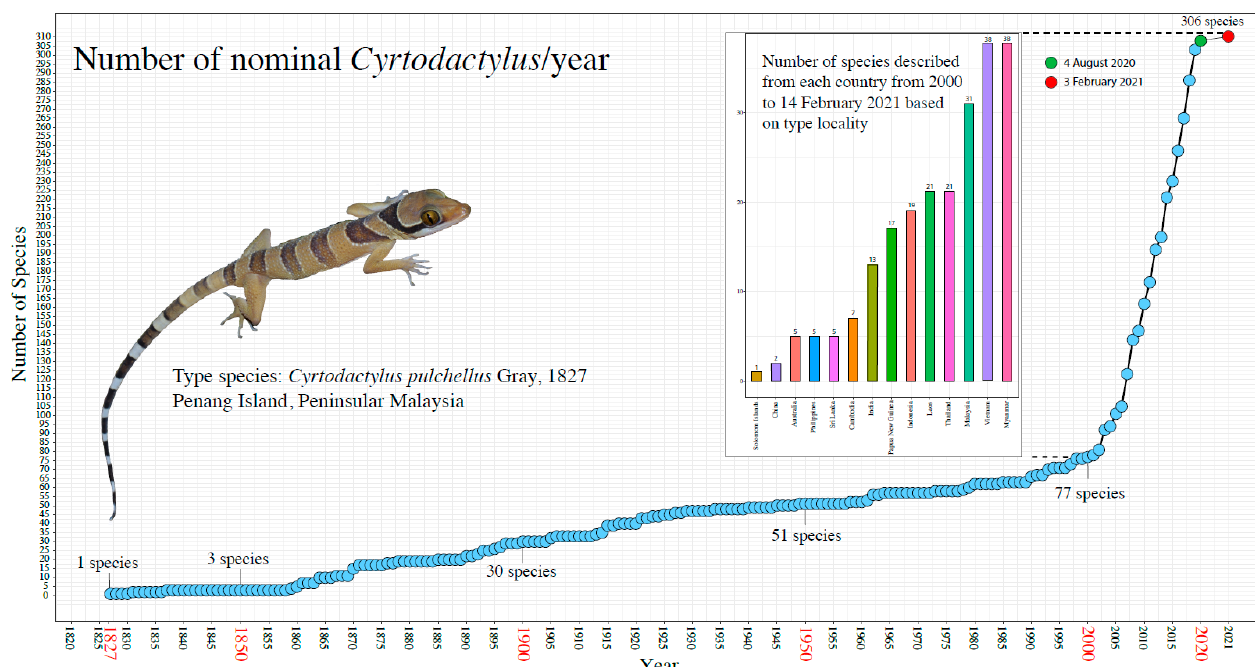
Figure 5. Cumulative number of species of Cyrtodactylus described per year. The trajectory of new species descriptions from 2000 to 18 March 2021 indicates that the true diversity of this genus is not yet calculable and that 48% of the newly described species during this period have come from Myanmar, Vietnam, and Malaysia.